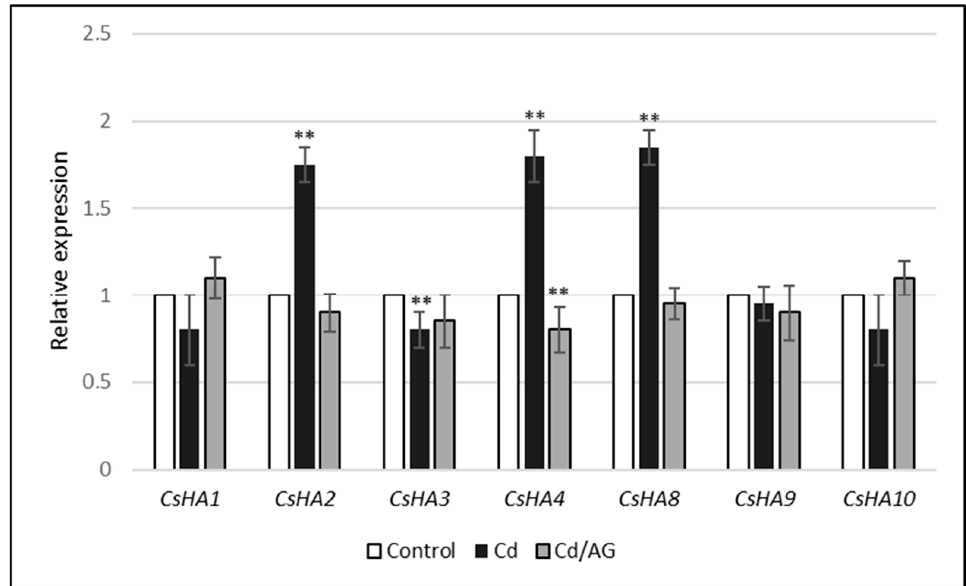
Figure 4. Relative expression of PM H + -ATPase genes in cucumber roots exposed to Cd and/or AG. To determine the expression of PM H + -ATPase genes, real-time PCR analysis was performed as described in the Materials and Methods. The RNA was isolated from the control roots (control) and roots treated with 10 µM Cd (Cd) or 10 µM Cd and AG (Cd/AG). Values are the means of three replications. Error bars represent SD (asterisks indicate the significant differences, where ** p < 0.01). Table 2. Transcript level of genes encoding plasma membrane H + -ATPase in the roots of Cucumis sativus L. For the normalization of expression of each CsHA gene, a gene encoding TIP41-like protein was used as the internal standard. Transcript Gene